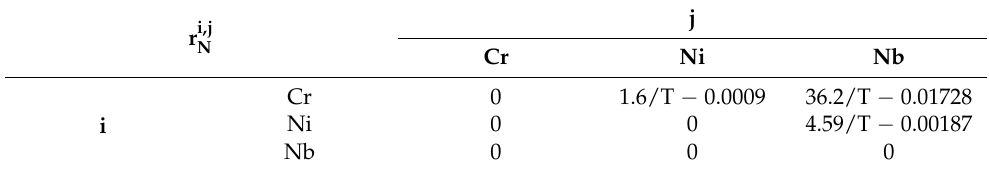
in liquid Fe-Cr-Ni-Nb system. Data from [10]. N